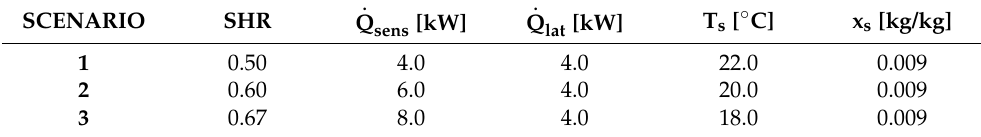
Table 3. Boundary conditions used in the simulations (part 2).